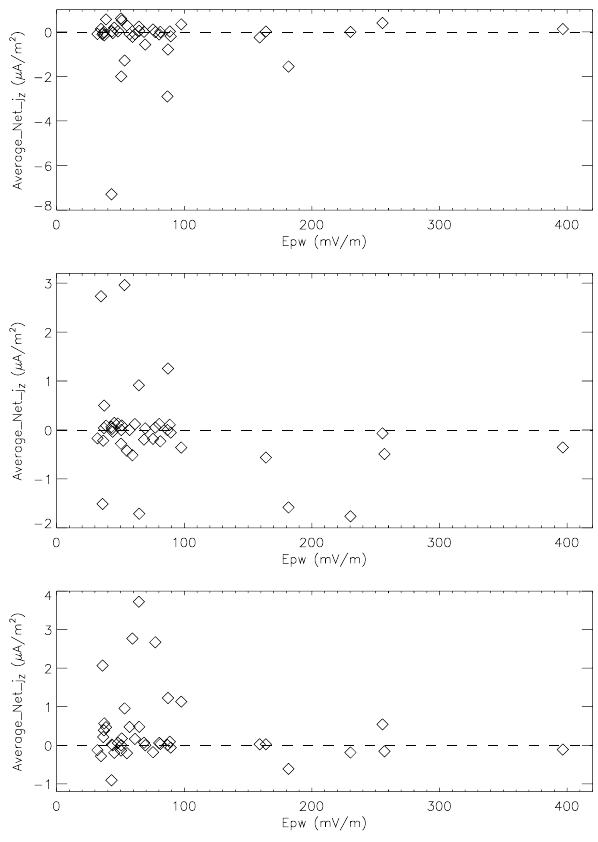
Fig. 10. Distribution of the average FAC density versus the electric field peak intensity ( E pw ) corresponding to three different regions. Top panel: equatorward region; Center panel: event region; Bottom panel: poleward region. Negative (positive) values indicate a net downward (upward) FAC density. These definitions are valid for both